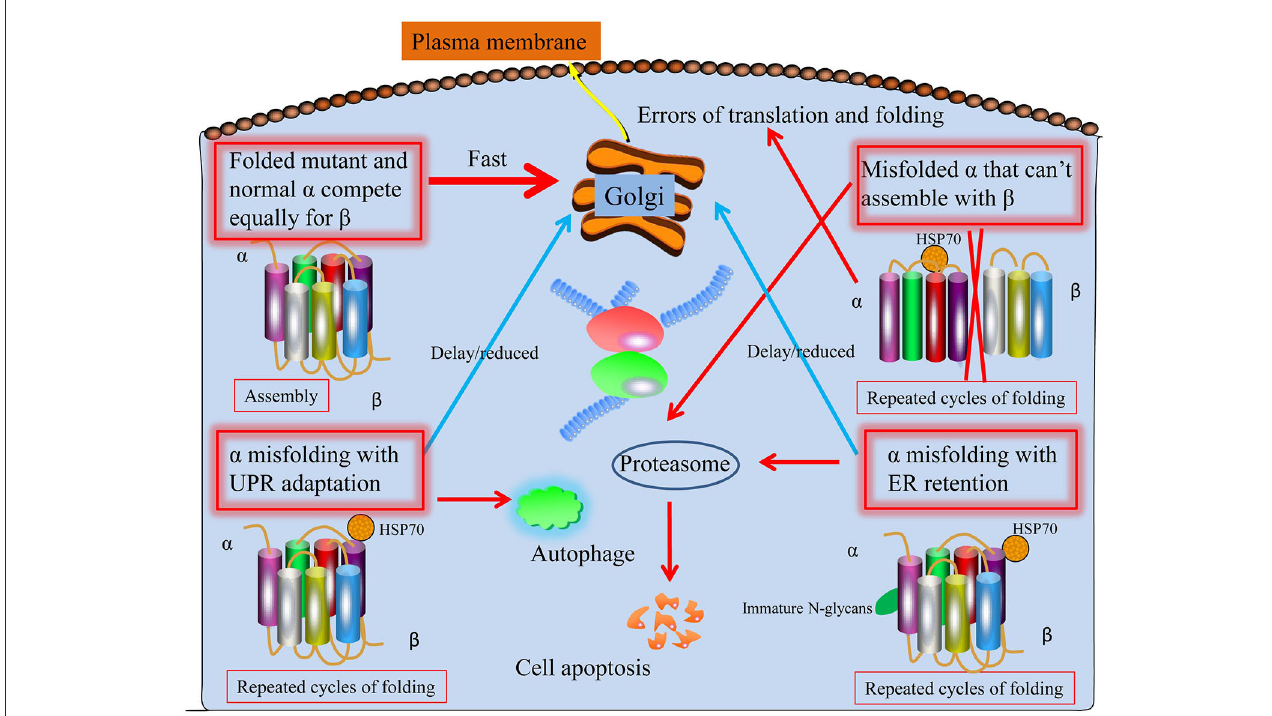
FIGURE1 Proposed four potential ways ATP1A3 mutations may proceed through the biosynthetic process. First, the protein folds and biosynthesizes normally; second, it undergoes irreversible misfolding and is subsequently degraded by proteasomes (ERAD); third, the presence of a chaperone assists biosynthesis; and fourth, the chaperone assistance is ineffective. As with HSP70, the shown chaperone is meant to stand in for various chaperone classes. Mutant and normal ATP1A3 alleles compete for the β subunit, making it difficult to anticipate the effects of ATP1A3 mutations. It is believed that every particular mutation that might worsen epilepsy disease severity may lie among these four